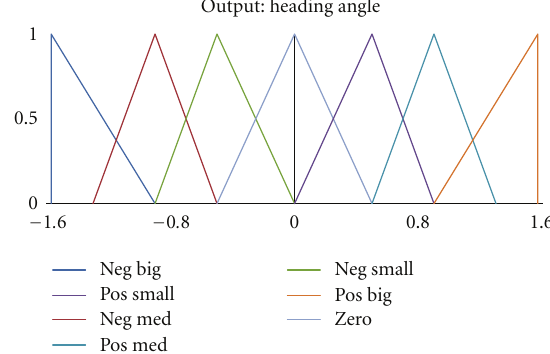
Figure 9: Output: heading angle